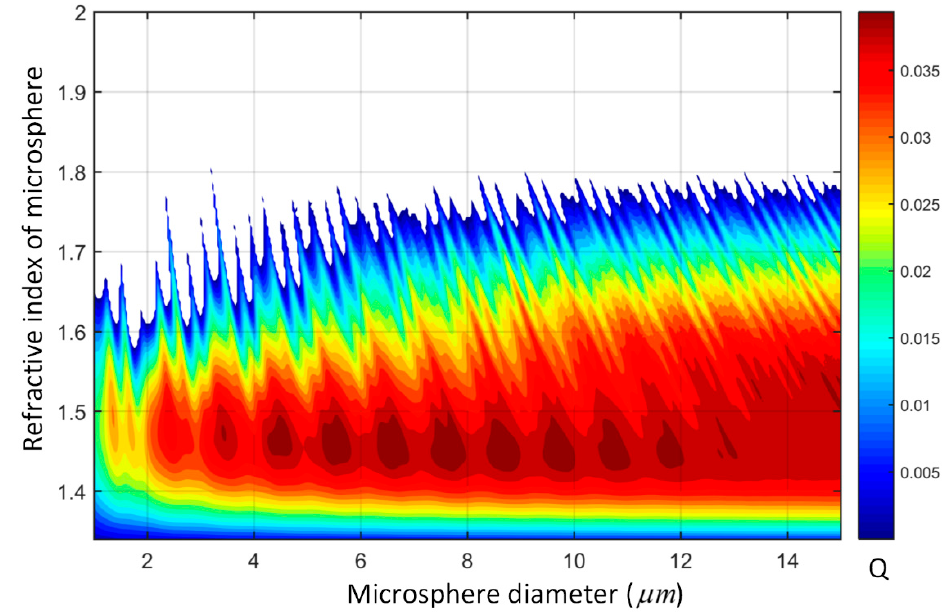
Figure 2. Trapping landscapes. The maximum reverse axial force in the direction of beam propagation is shown, in terms of the trapping e ffi ciency Q as a function of refractive index and microsphere diameter. The trapping e ffi ciency Q can be converted to the maximum reverse axial force by multiplying by n m P / c , where n m is the refractive index of the immersion medium, P is the beam power at the focus, and c is the light speed in free space. An objective with NA = 0.9 is used to focused the 1064 nm trapping beam, and the water is used as the immersion medium in simulations. The trapping landscape can be divided into two portions approximately. In the lower portion, we can see that microspheres with relatively low refractive index ( n < 1.8) can be trapped. In the upper portion, microspheres with high refractive index ( n > 1.8) are hard to be trapped with the used NA.